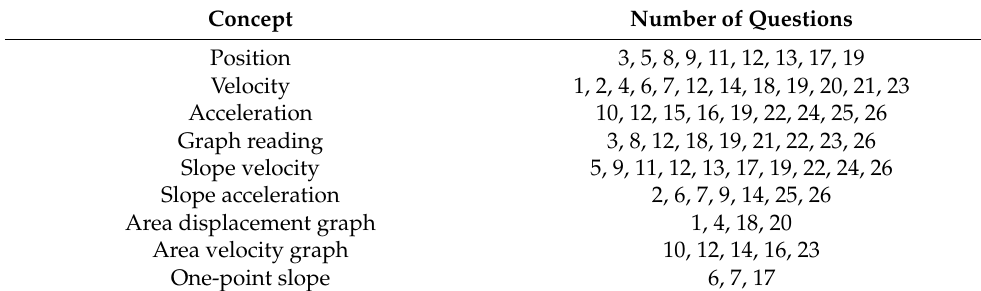
Table 1. Distribution of questions according to